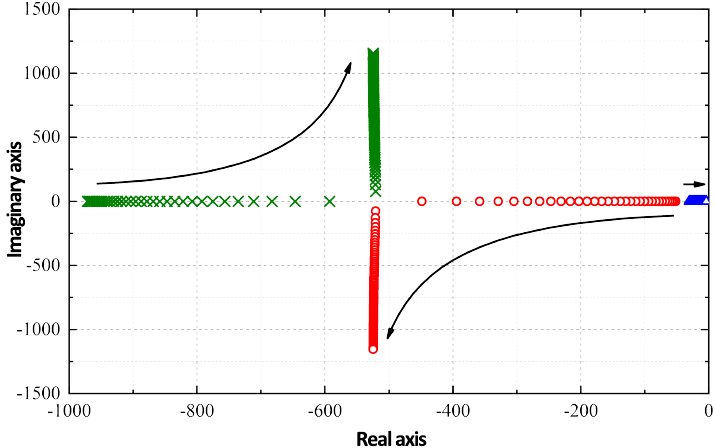
Figure 13. Pole placement of the closed-loop transfer function of speed estimation.